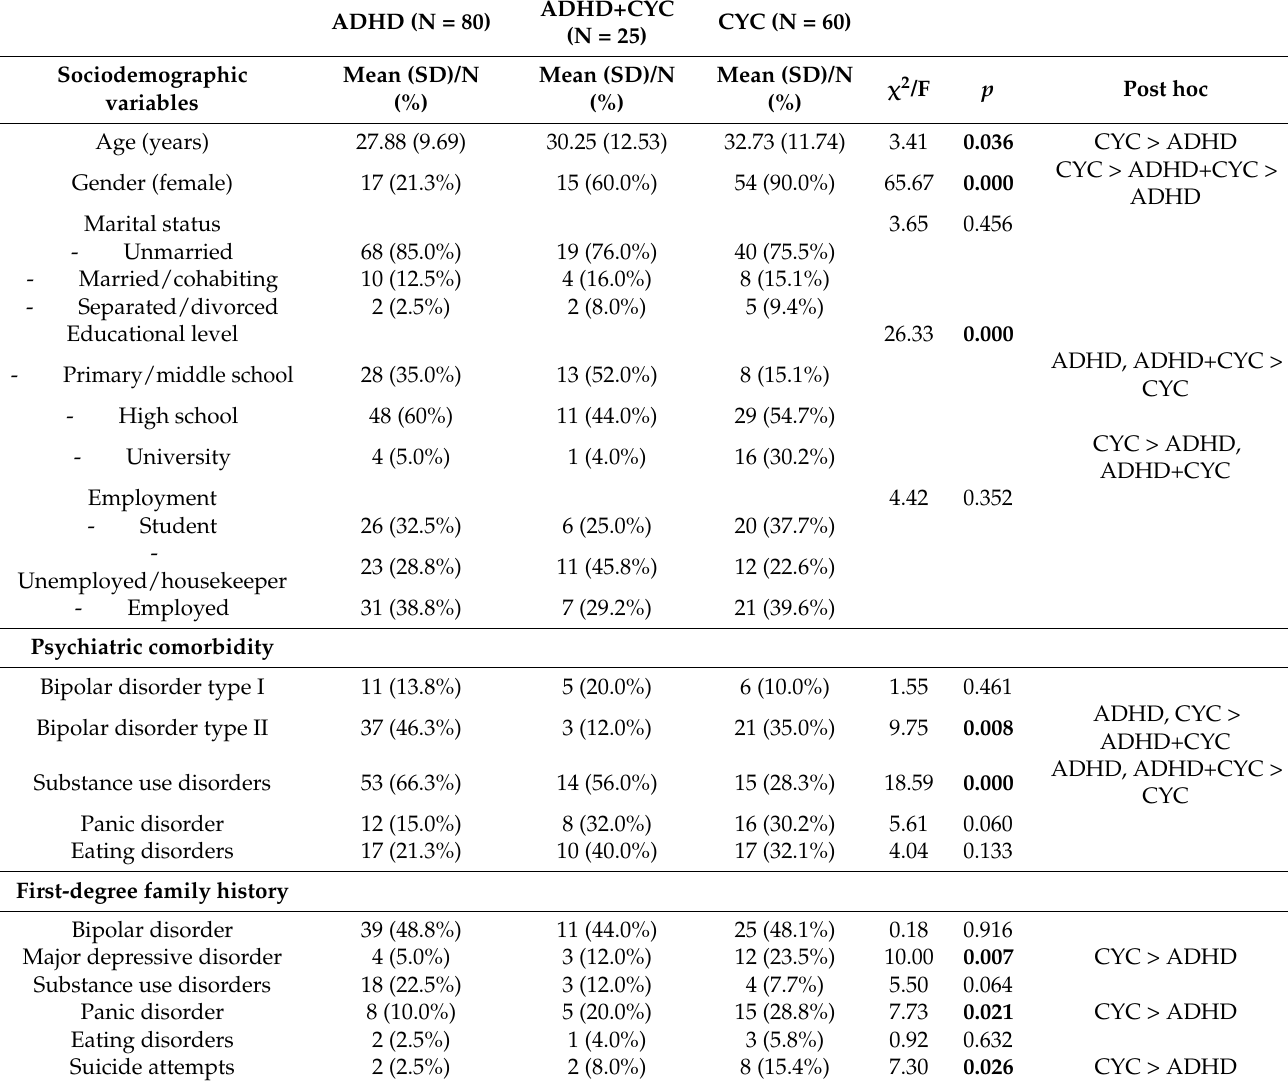
Table 1. Differences in sociodemographic variables, psychiatric comorbidity, and family history of psychiatric disorders among patients with ADHD, cyclothymia (CYC), or both (ADHD+CYC). One-way ANOVA was used for age; chi-square tests were used for other variables. F-statistics and χ 2 -statistics are reported. p -values < 0.05 are shown in